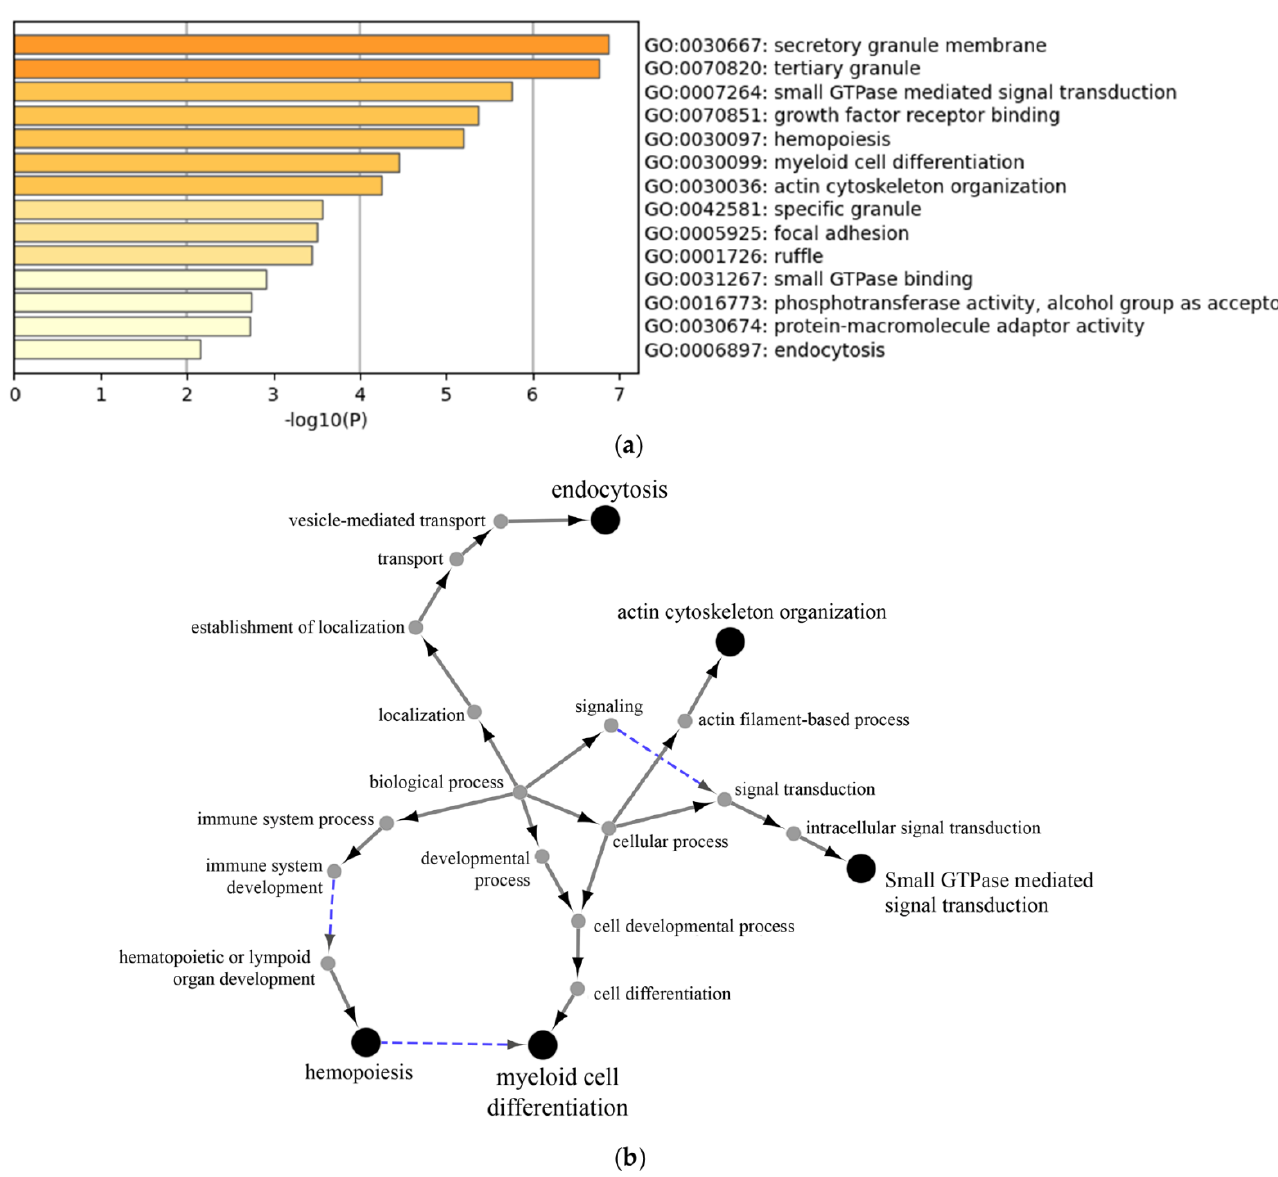
Figure 6. Gene ontology enrichment analysis of proteins upregulated by LPS in neutrophil-derived EVs only during asthmatic exacerbation. Enrichment clusters identified by Metascape ( a ) and functional analysis of enriched GO terms from the parent node to the root node, illustrated with ClueGo and Cluepedia in Cytoscape ( b ).